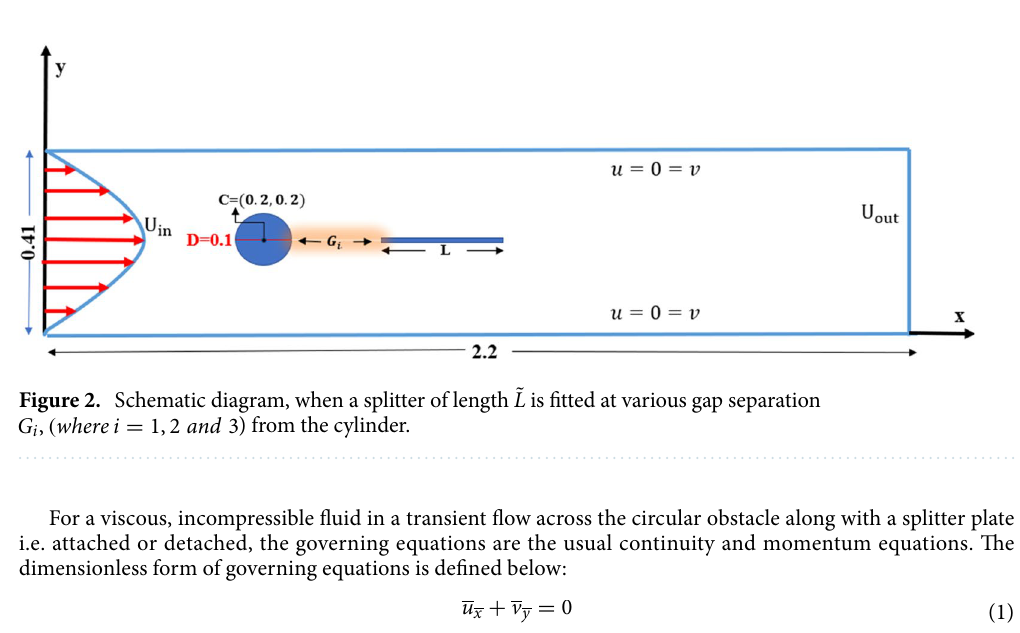
Figure 1. Schematic diagram, when a splitter of length L i , where i = 1, 2 and 3 is attached with the cylinder.